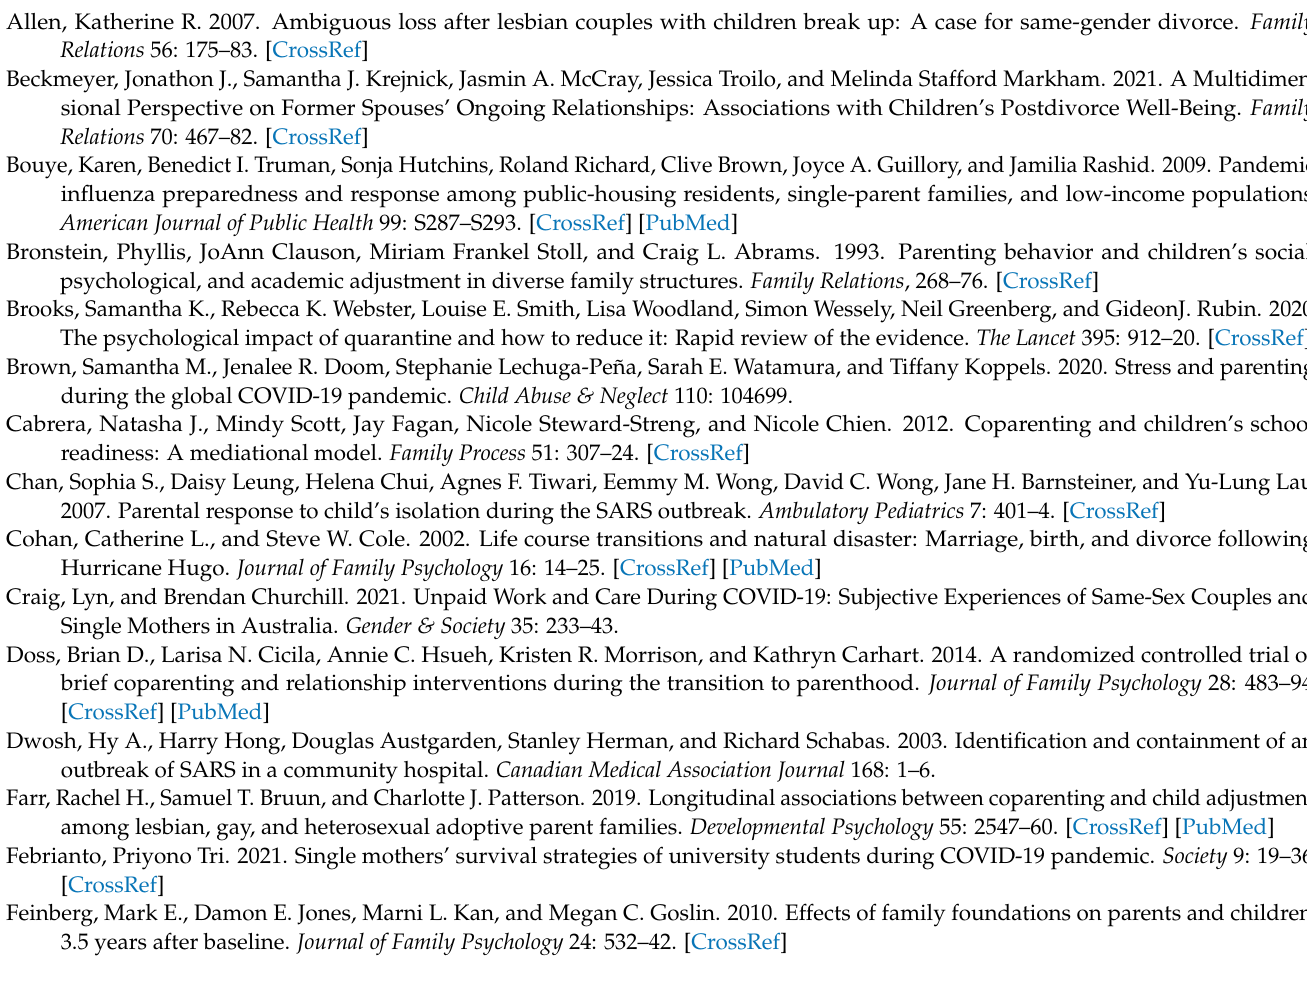
Figure S4: Divorced /separated. Figure S5: income above 60K. Figure S6: income below